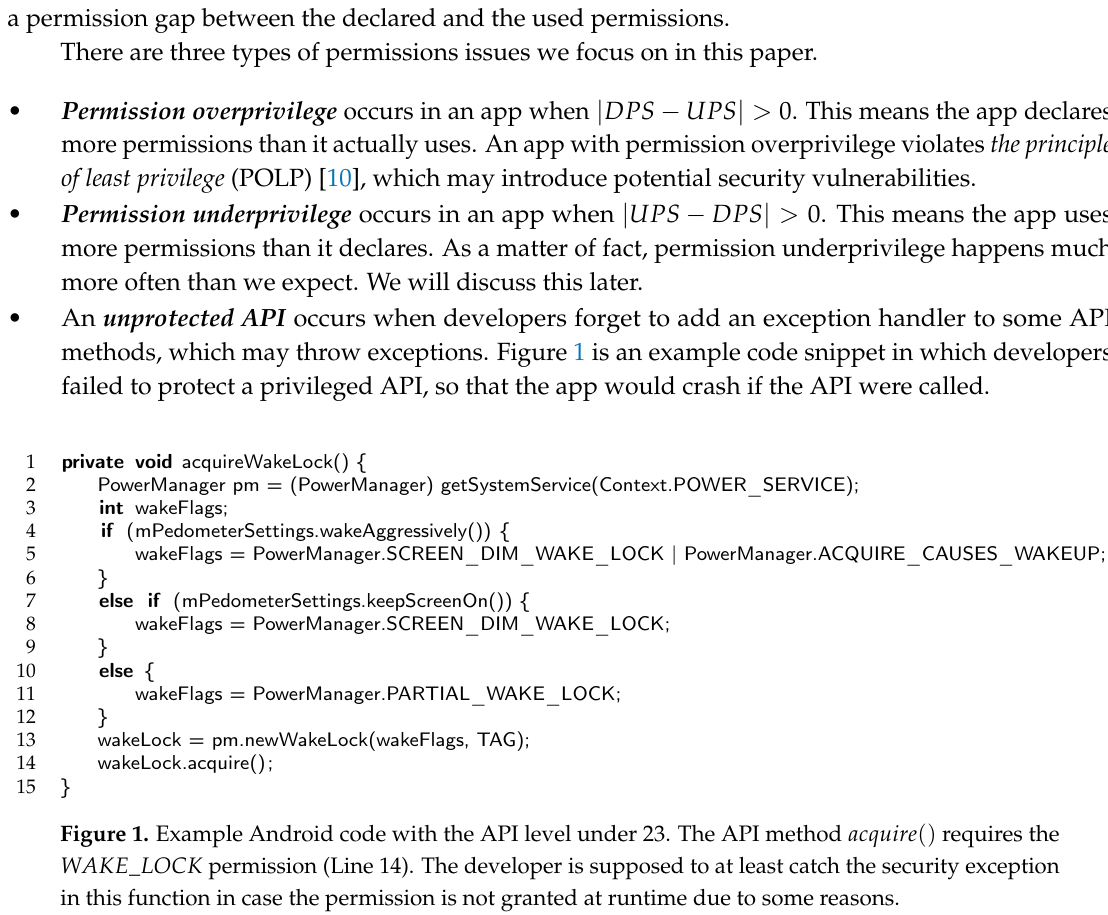
Figure 1. Example Android code with API level under 23. The API method acquire () requires